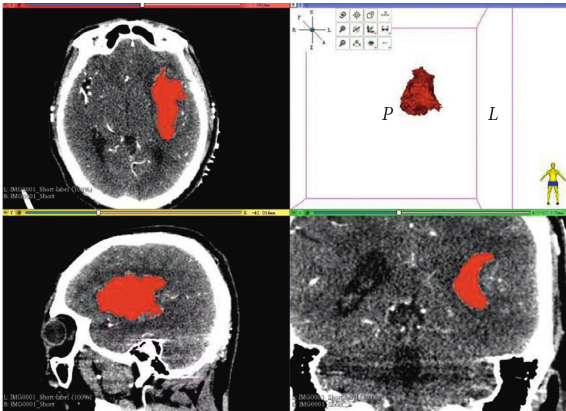
Figure 2: Three-dimensional image of intracranial